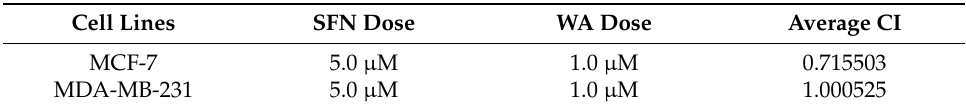
Figure 2. Combinatorial WA and SFN promote increases in surface area of breast cancer cells. MCF-7 and MDA-MB-231 breast cancer cells as well as the non-cancerous MCF10A cells were treated with predetermined optimized concentrations of 5.0 µM SFN or 1.0 µM WA singly and both compounds at the same concentrations for 3 days where DMSO serves as the control. Photographs were taken on the fifth day of culture. Table 1. CompuSyn data of MTT values indicate combinatorial synergy in MCF-7 cells. CI: combination index.